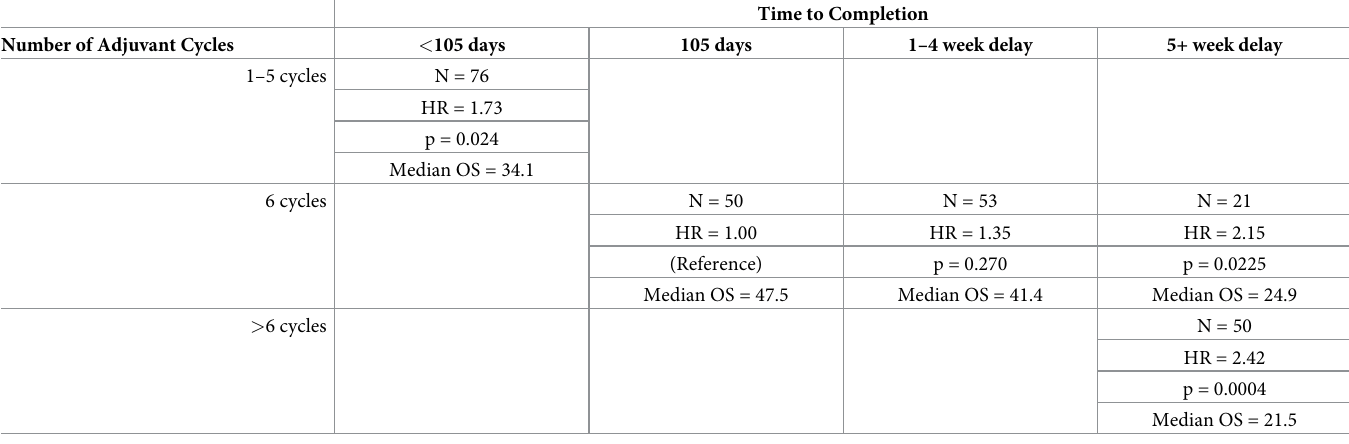
Table 2. Interaction between number of cycles and the time to complete adjuvant